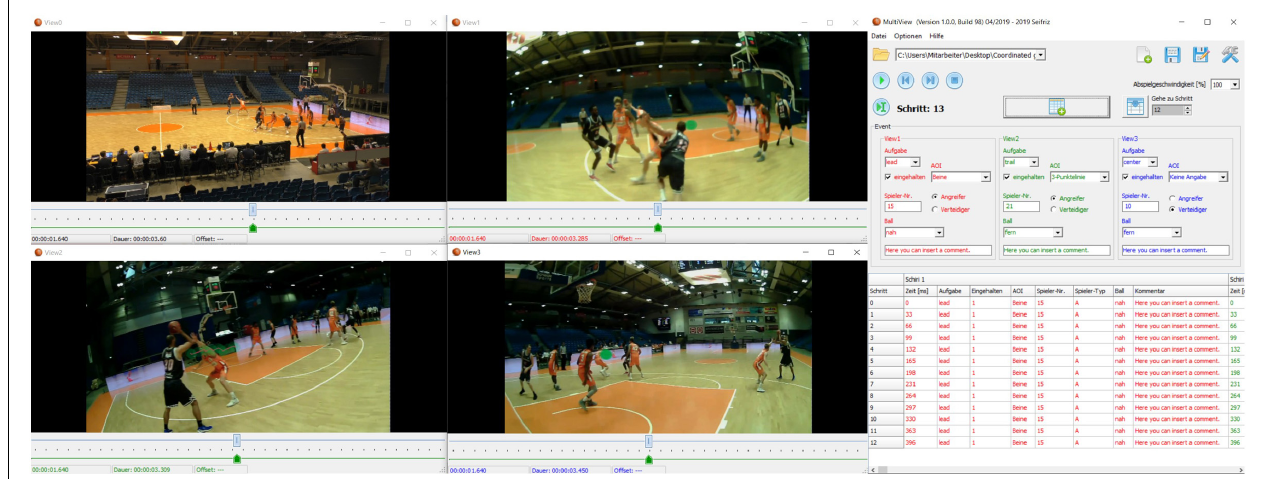
FIGURE 2 | Screenshot of the user interface of the analysis tool enabling the analysis of four video streams at the same